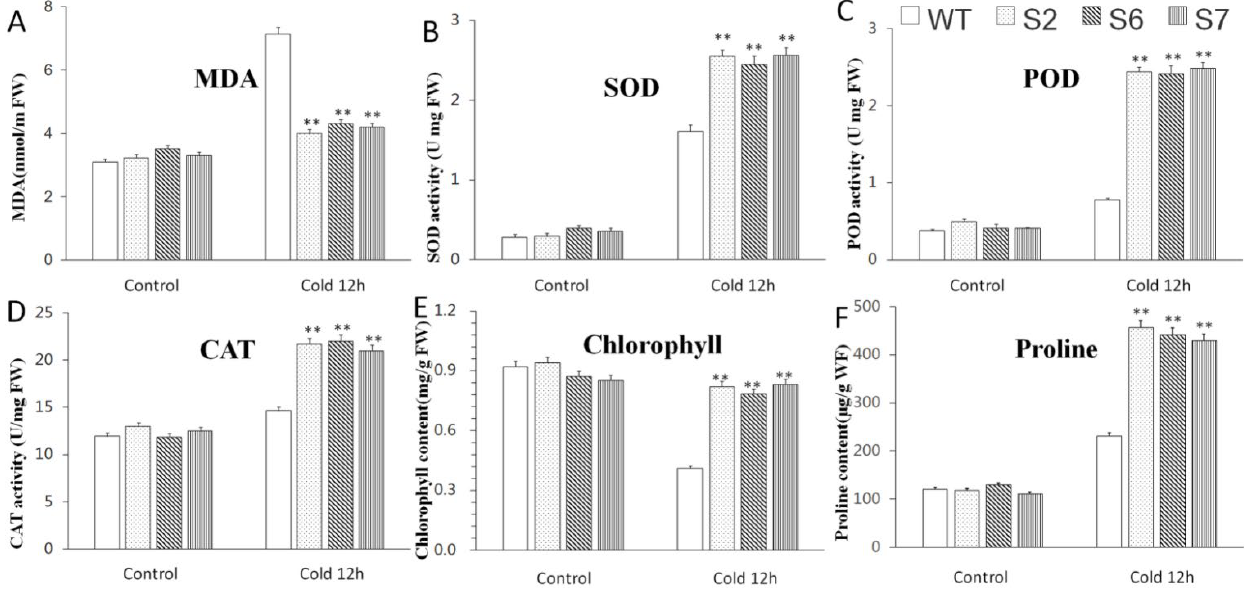
Figure 5. Effects of overexpression of VvWRKY28 on physiological and biochemical indexes of A. thaliana under low temperature. ( A ) MDA content; ( B ) SOD activity; ( C ) POD activity; ( D ) CAT activity; ( E ) Chlorophyll content; ( F ) Proline content. The standard error was the average of 3 repeated tests. The asterisk above the column indicated that there was a very significant difference between the transgenic lines and the WT lines, ** p ≤ 0.01.